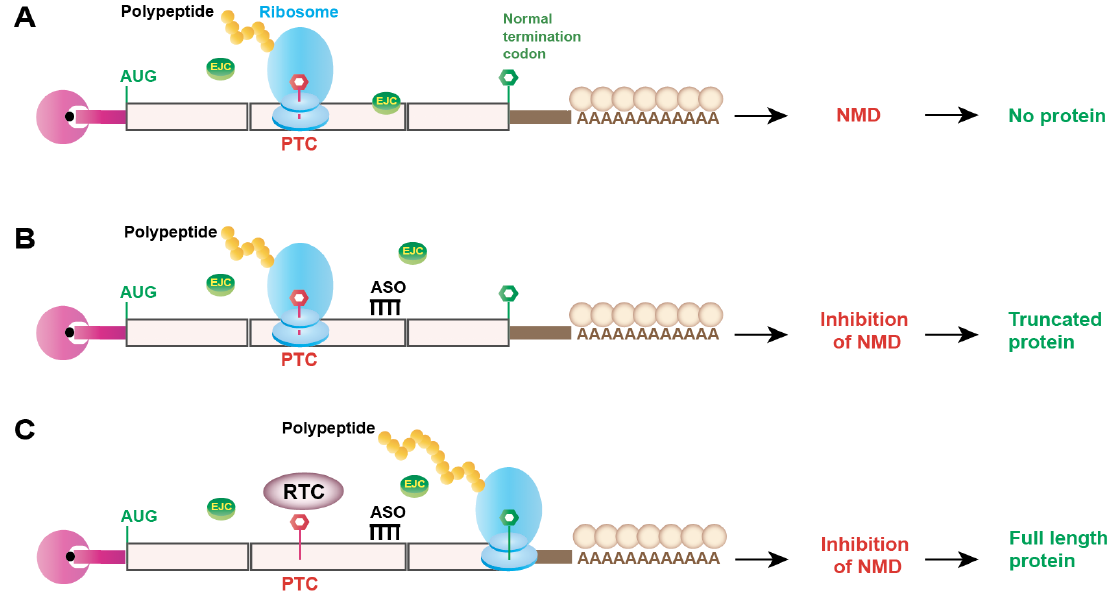
Figure 6. Gene-specific NMD inhibition and targeted augmentation of protein synthesis. ( A ) A premature termination codon (PTC)-containing mRNA is degraded by nonsense-mediated mRNA decay (NMD), inhibiting the expression of the encoded protein. ( B ) Antisense oligonucleotides (ASO) targeting gene-specific exon junction complex (EJC)-binding sites can inhibit NMD, allowing the expression of a truncated protein from a PTC-containing mRNA. The truncated protein may or may not be functional depending on the presence or absence of the functional domain(s). ( C ) Gene-specific ASO-mediated NMD inhibition, along with the readthrough compound (RTC), can allow the expression of a full-length protein from a PTC-containing mRNA.